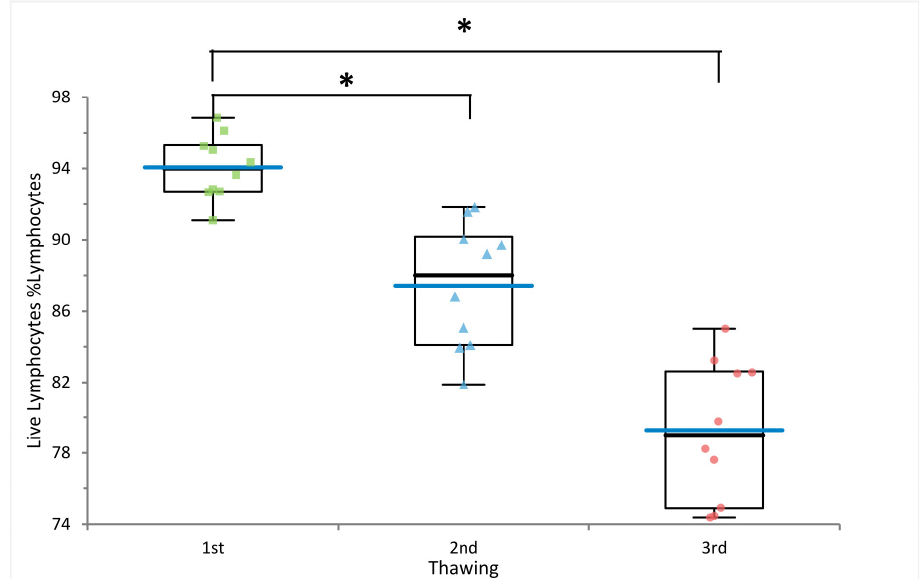
Figure 2. Lymphocyte viability. Comparison of lymphocyte viability measured on ten PBMC samples after the first, second, and third freezing cycle. * p ‐ values from the paired t ‐ test < 0.05. Blue bars indicate mean values.